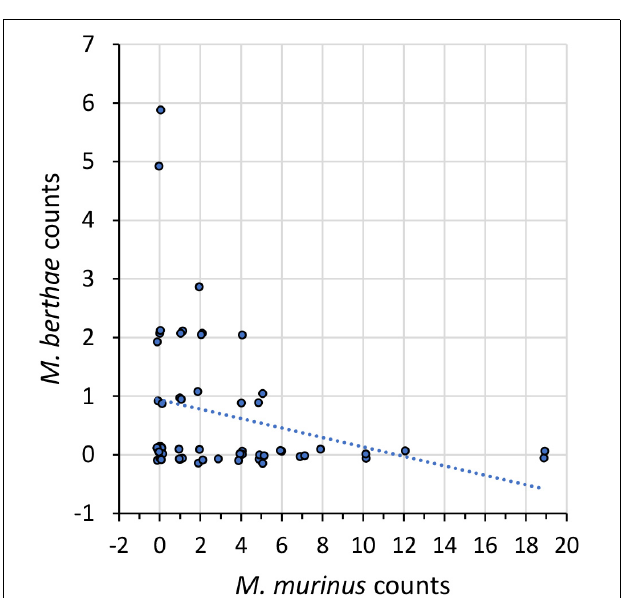
FIGURE 1 | Spatial association of M. berthae with M. murinus . Scatter plot shows the numbers of M. berthae sighted within a transect walk as a function of those of M. murinus on the same walk for all transect walks. Points have been modified by a small uniform jitter in each coordinate ( SD = 0.144) to visualize multiple observations, while the dotted line is the least-squares fit (provided only as a visual aid, it is not a regression line as data are not normally distributed). These counts represent data pooled over all scenarios. The figures corresponding to each of the four scenarios for M. murinus and M. berthae can be found in Online Resource 2.